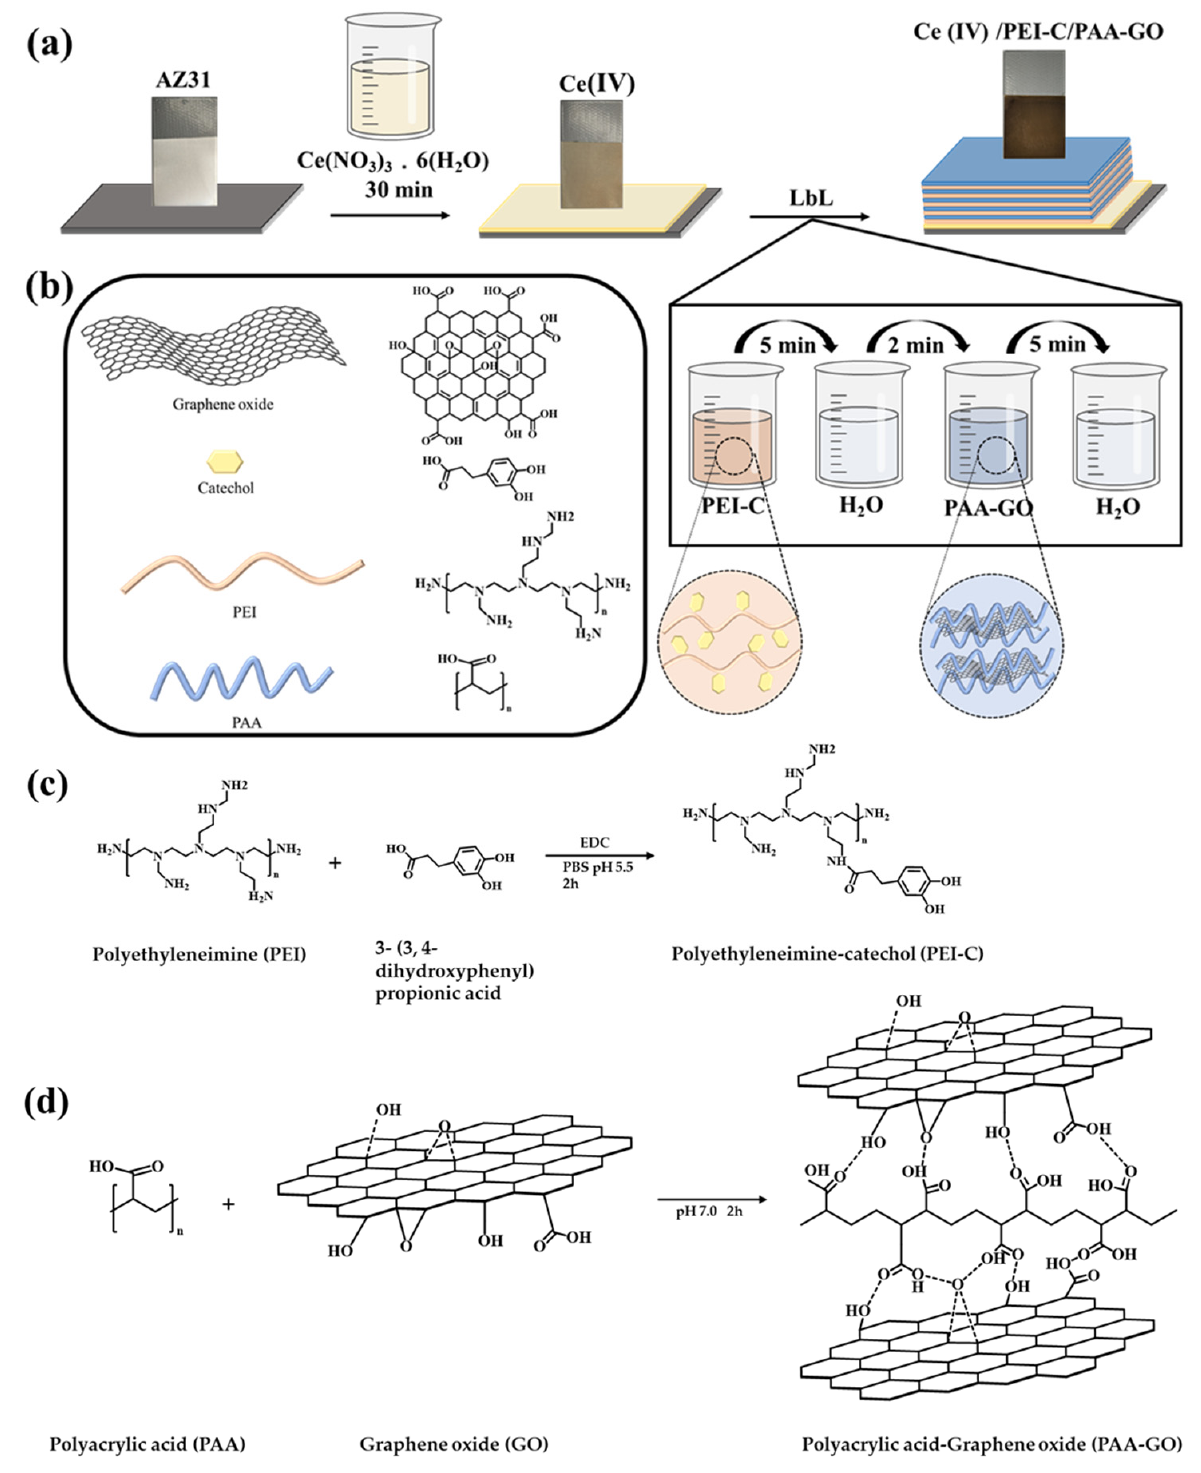
Figure 1. ( a ) The preparation process of the self-healing anti-corrosion coating and ( b ) the chemical structures of graphene oxide, catechol, PEI, and PAA. The chemical cross-linking scheme of ( c ) the polymer PEI with catechol-containing supramolecules and ( d ) the polymer PAA with graphene ox- ide.